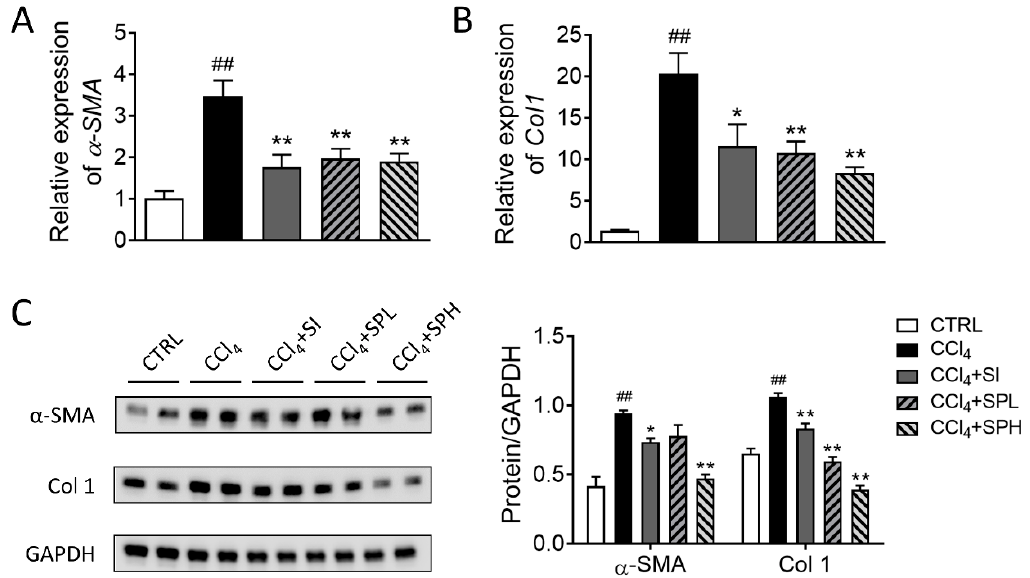
Figure 5. Effects of spore powder of A. camphorata on the expression of α -SMA and Col1 in liver tissues from mice treated by CCl 4 . The transcription levels of α -SMA (A) and Col 1 (B) genes in the liver tissues. (C) The translation levels of α -SMA and Col 1 genes in the liver tissues. Data are presented as mean ± SEM (n = 6). Different letters indicate significantly different values according to a one-way ANOVA using Tukey’s test for multiple comparisons. Compared with control group (CTRL), ## p < 0.01; compared with CCl 4 -induced group (CCl 4 ), * p < 0.05, ** p < 0.01. α -SMA, α -smooth muscle actin; Col 1, collagen I; GAPDH, Glyceraldehyde-3-phosphate dehydrogenase. CTRL, control group; CCl 4 , carbon tetrachloride; SI, silymarin; SPL, low-dose treatment with spore powder of A. camphorata ; SPH, low-dose treatment with spore powder of A. camphorata .